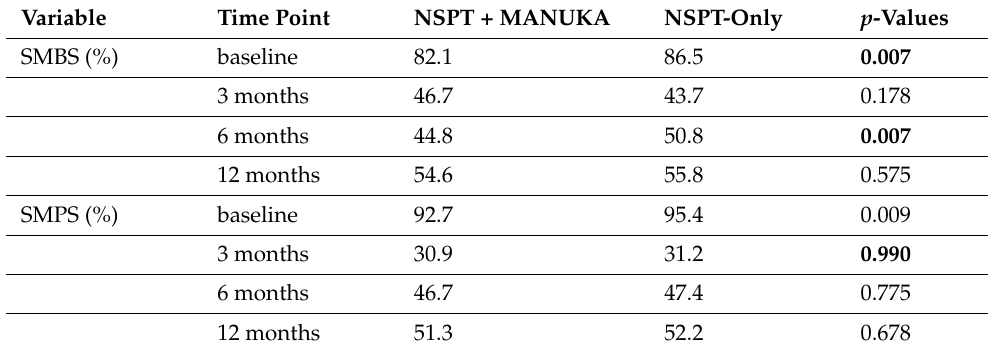
Table 2. Measured values of split-mouth bleeding score and split-mouth plaque score, represented as percentages of positive sites in respective quadrants